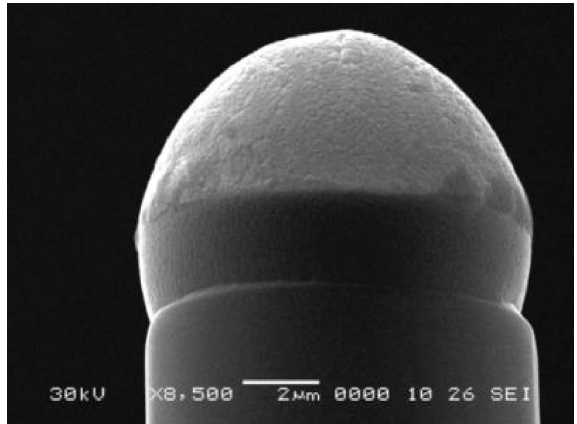
Figure 12: SEM image of the vertex of Si NWs, at the TPL dis- placement on the catalyst droplet surface during the formation of a recrystallization (Figure 14(a), 14(b), and 14(d)), i.e., without the initial cone shape (Figure 14(c)).